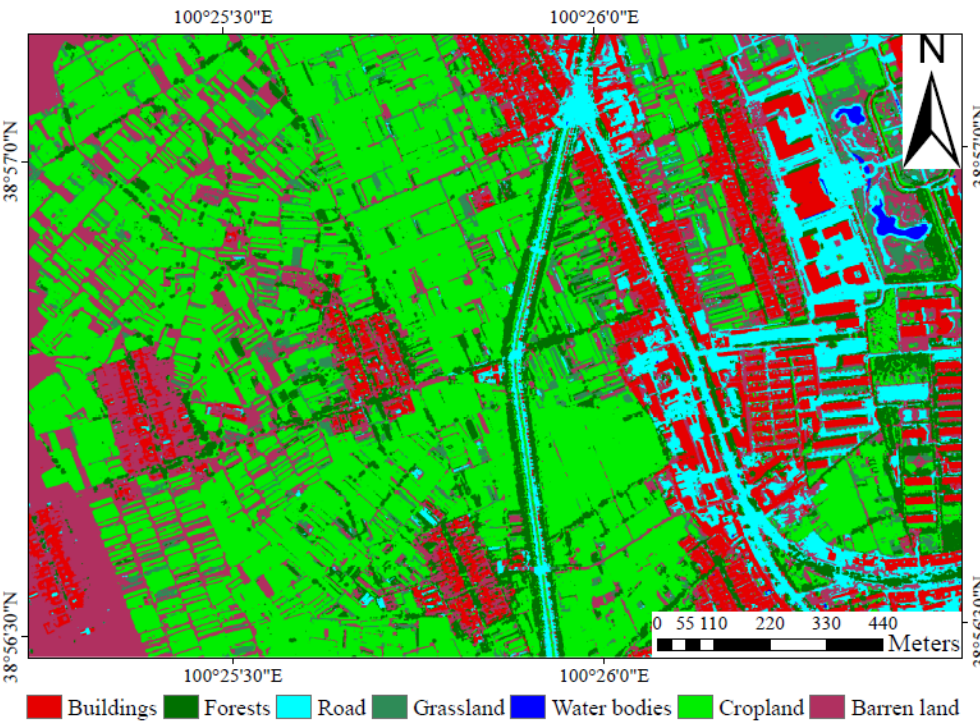
Figure 7. Land cover classification map using the SVM classifier based on the layer stacking fusion method at a 1 m spatial resolution (OA = 97.8%, kappa = 0.964).